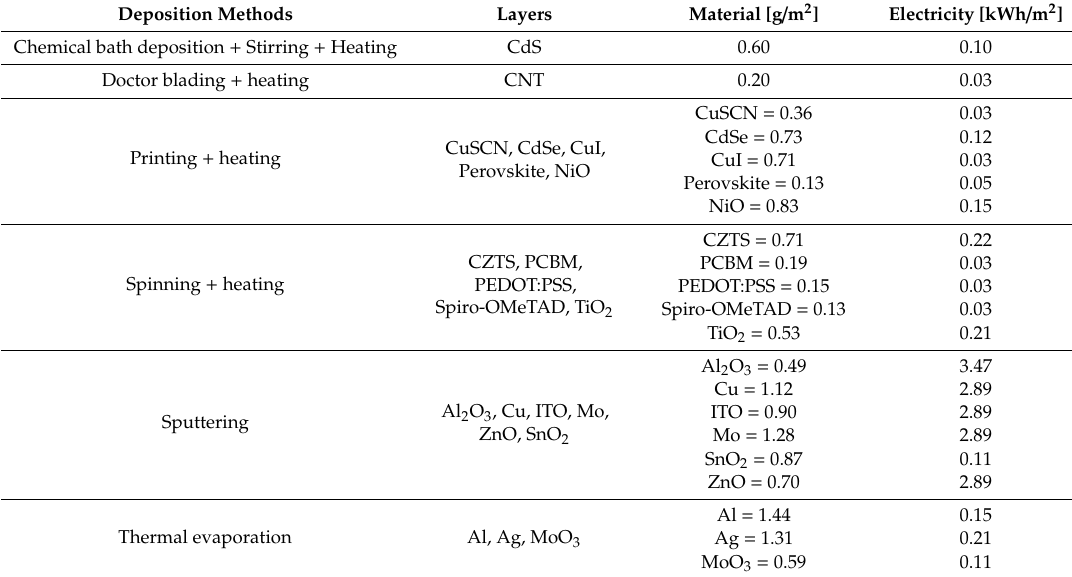
Table 1. Deposition methods used in layer processing and their electricity and material inventories (per 100 nm thick